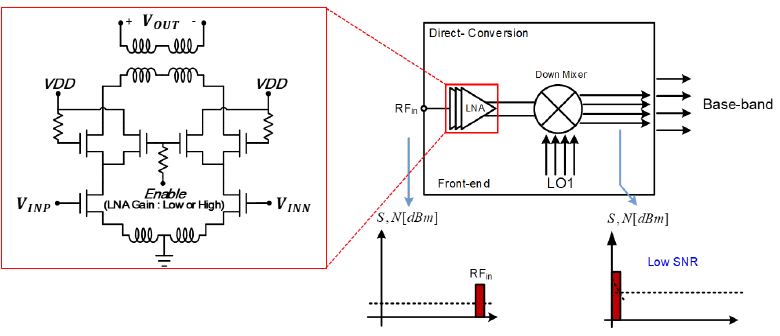
Figure 10. Direct conversion receiver